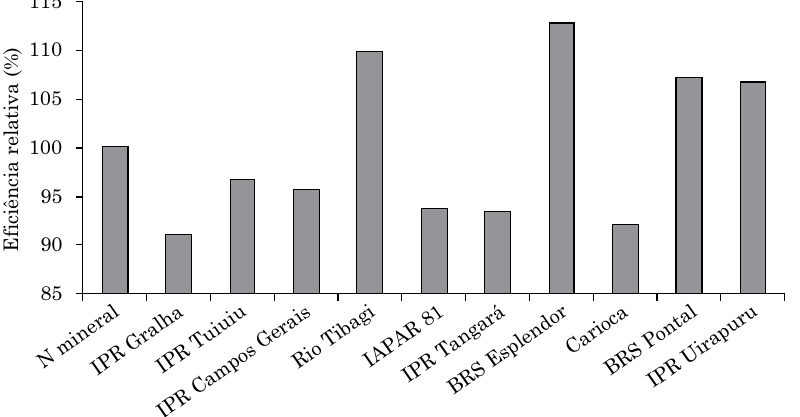
Figura 5. Eficiências relativas médias da inoculação de sementes de cultivares de feijão com Rhizobium freirei em relação à adubação